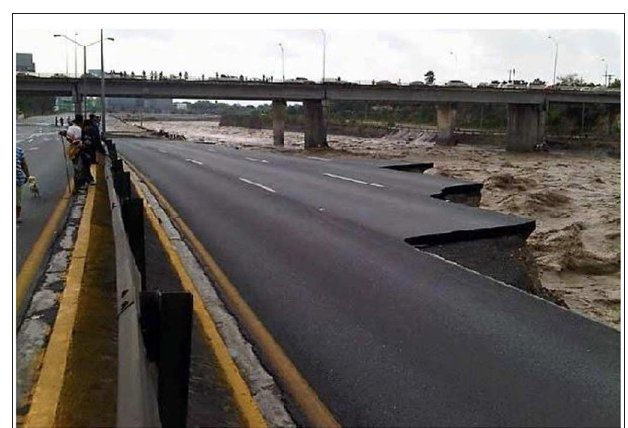
FIGURE 4 | The Santa Catarina River during Hurricane Alex, July 2010. Courtesy from the National Water